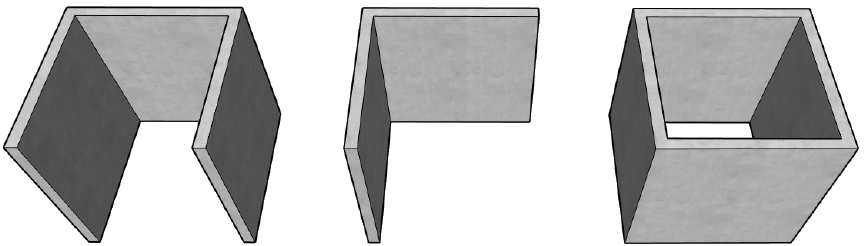
Figure 2. Assembled shear walls: U-shaped, L-shaped and closed cross-section shear